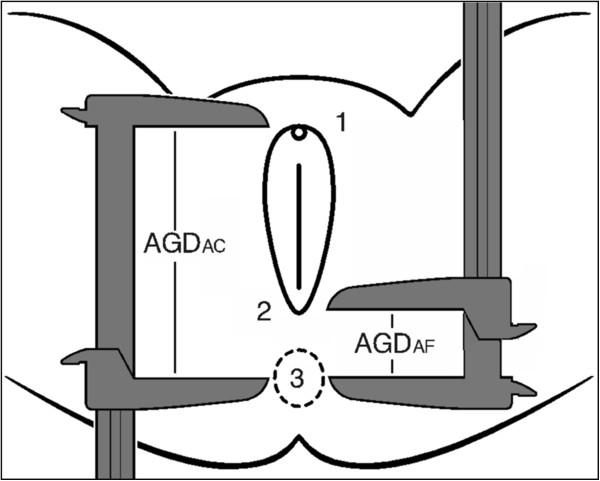
Landmarks for two measurements of AGD: AGDAC, from the anterior clitoral surface to the center of the anus (point 1 to point 3); and AGDAF, from the posterior fourchette to the center of the anus (point 2 to point 3). Adapted with permission from Sathyanarayana et al.
[27].